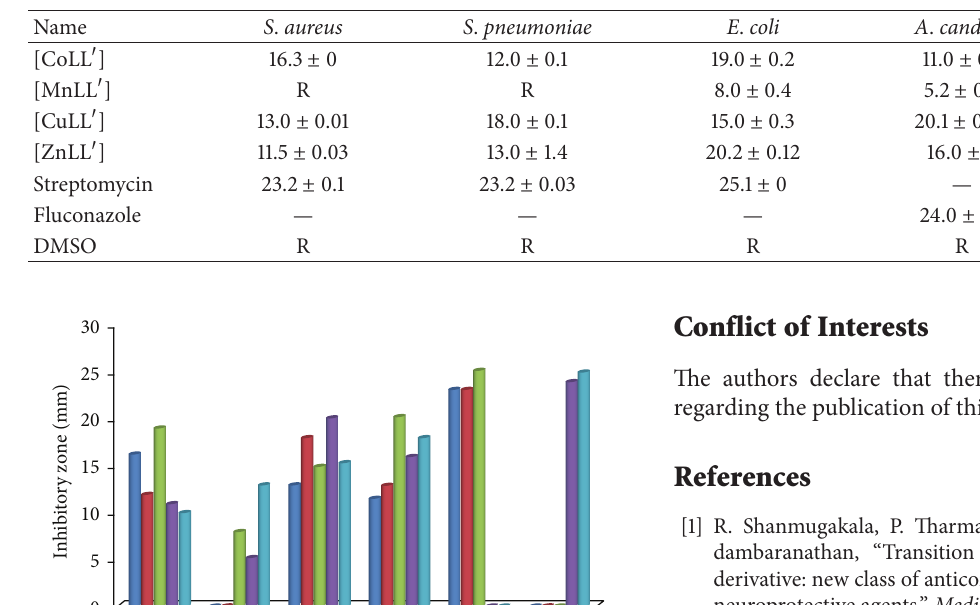
Table 3: Summary of antimicrobial screening of the mixed ligand complexes.